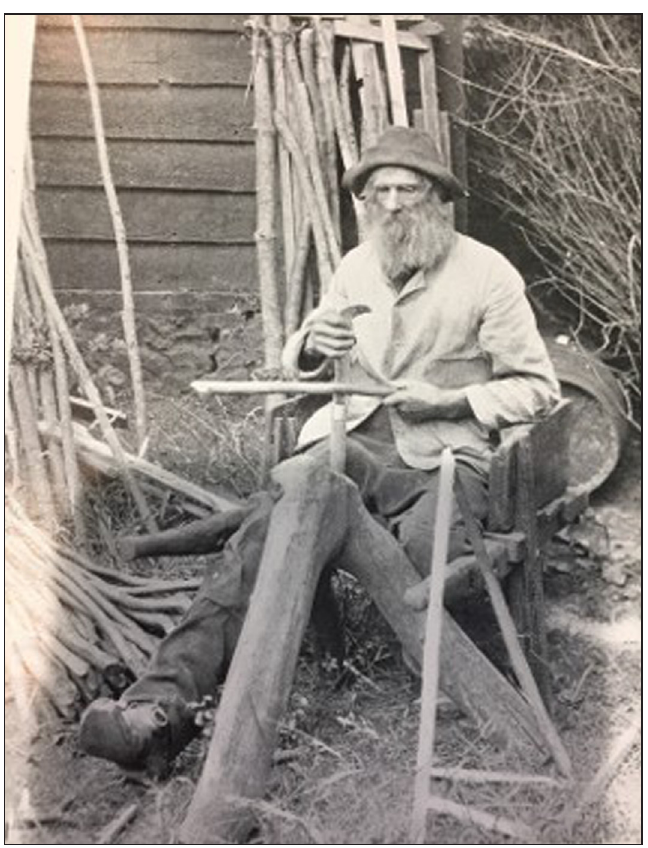
Fig. 11 : James Minns, ‘Rough Jimmy’, Country Life , 12 October 1901. Author’s